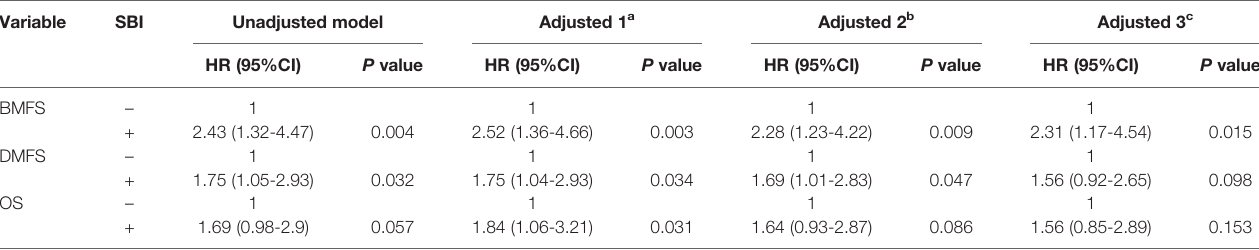
TABLE 2 | Tumor progression and survival analyses by the presence of skull base